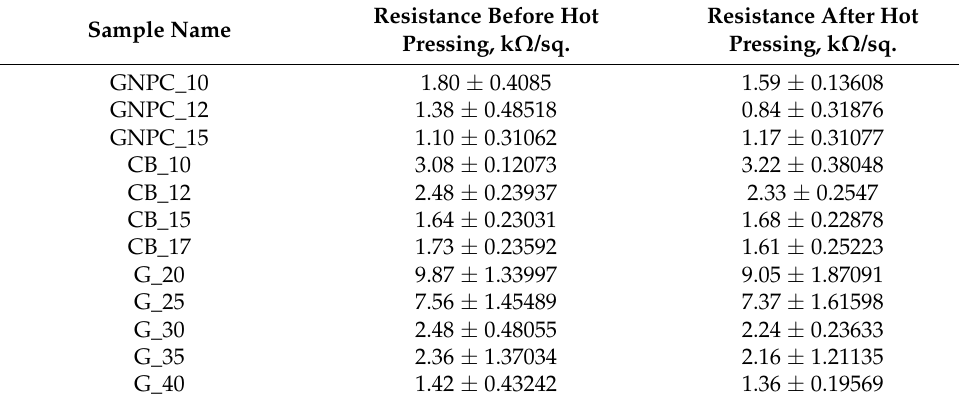
Table 3. Detailed Results of Resistance Measurements Before and After a Hot Pressing Process for Heaters Screen-Printed with Different